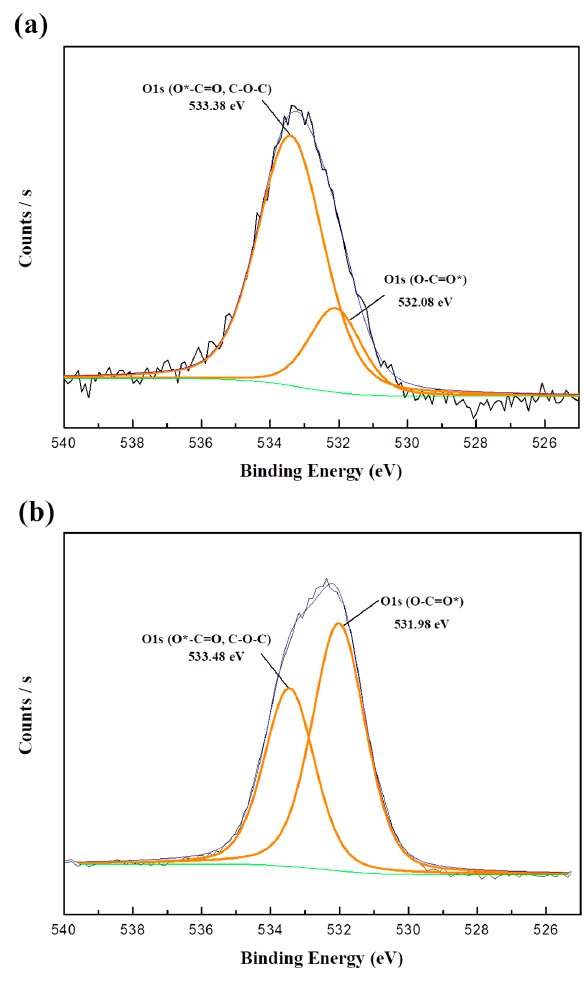
Figure 10. O1s fit theory of ( a ) PFD/PU-01, and ( b ) PFD/PU-03.